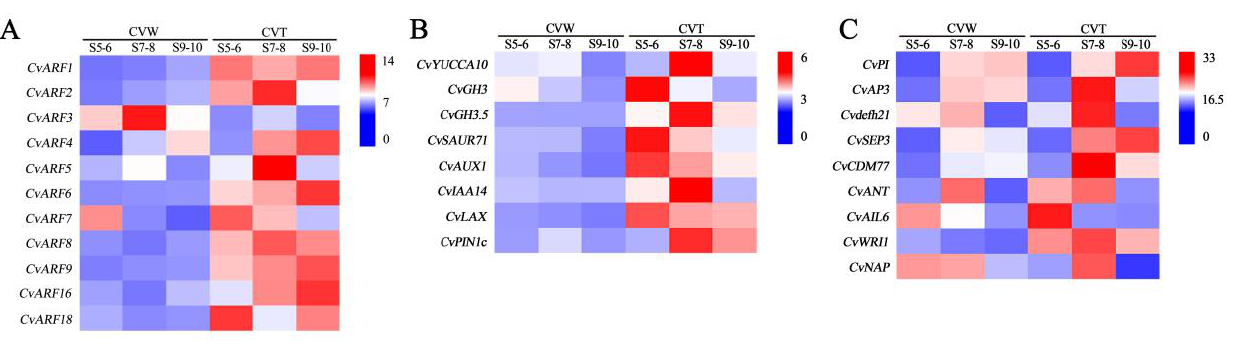
Figure 8. The expression patterns of DEGs in different samples were validated by real-time quanti- tative polymerase chain reaction (qRT-PCR). ( A ) Expression analysis of CvARFs in CVW and CVT at different developmental stages. ( B ) The expression patterns of genes related to auxin synthesis, transport, and response in CVW and CVT at different developmental stages. ( C ) Expression analysis of genes related to flower development in CVW and CVT at different developmental stages.